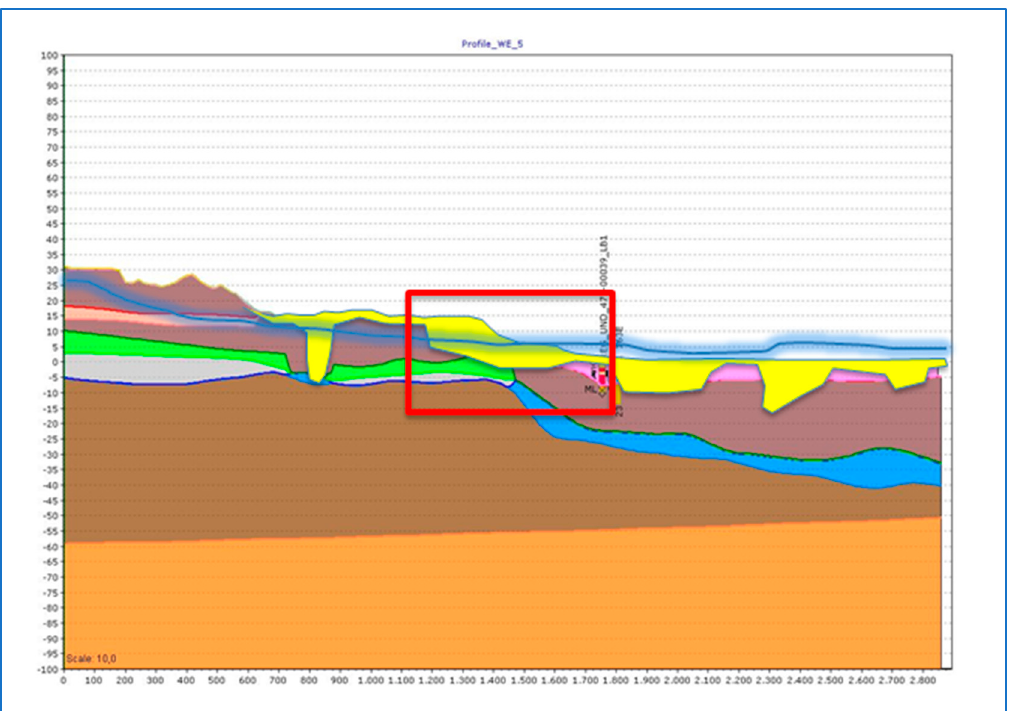
Figure 4. Location of projects used for development of a conceptual design of The Odense Model. (SK/VR) Skibhuskvarteret/Vinkælderrenden, (TBT) Thomas B. Thrigesgade, (ST) Sanderum Tørvehave, (New OUH) New Odense University Hospital (for descriptions see Table 5).